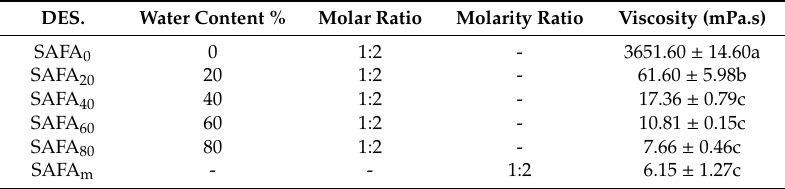
Table 1. DESs preparation and corresponding viscosities.